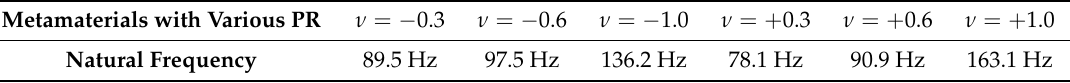
Table 3. Vertical first-order natural frequency of metamaterials corresponding to various